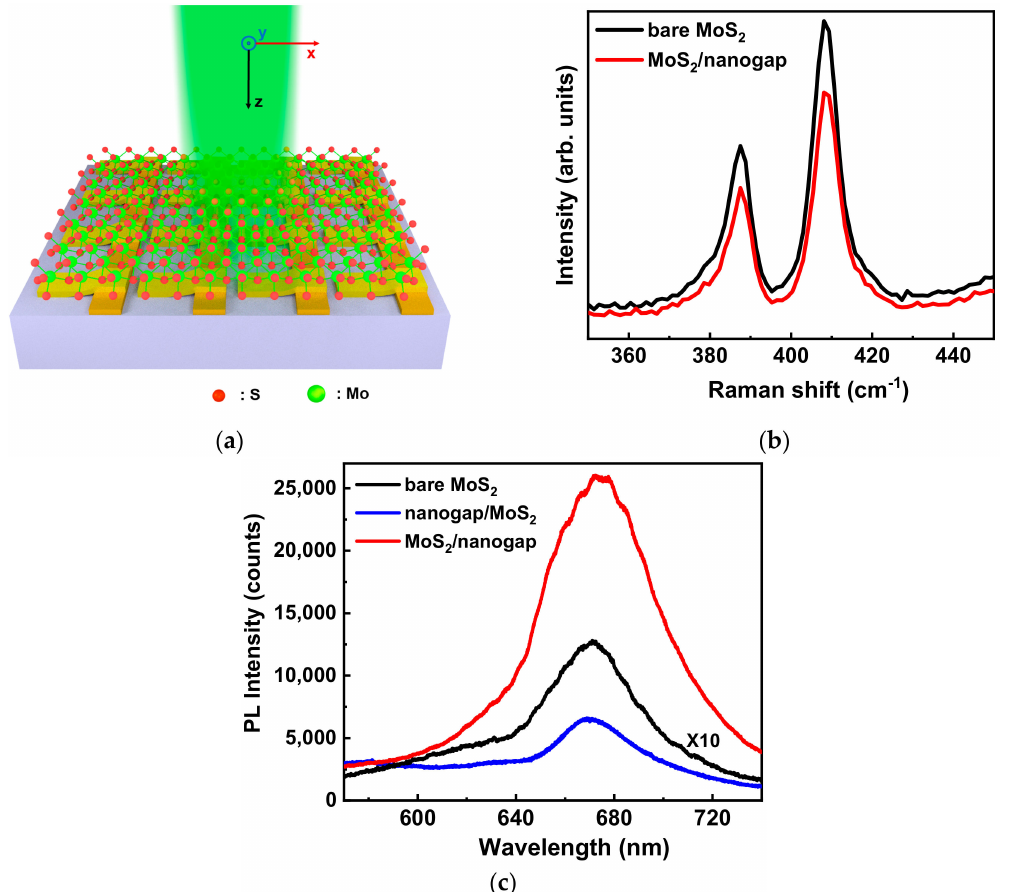
Figure 3. ( a ) Schematic illustration of the photoluminescence (PL) measurements on MoS 2 /